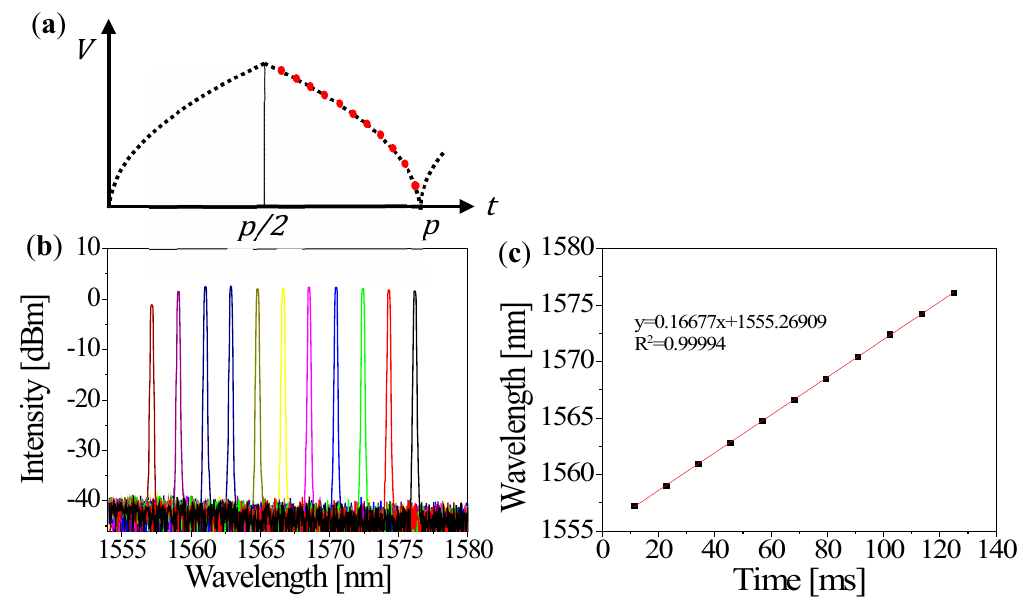
Figure 3. ( a ) OSA peak hold mode spectra of the linearized wavelength-swept thermo-optic laser output; ( b ) Time domain tracing of the laser output at swept rate ( f of 16